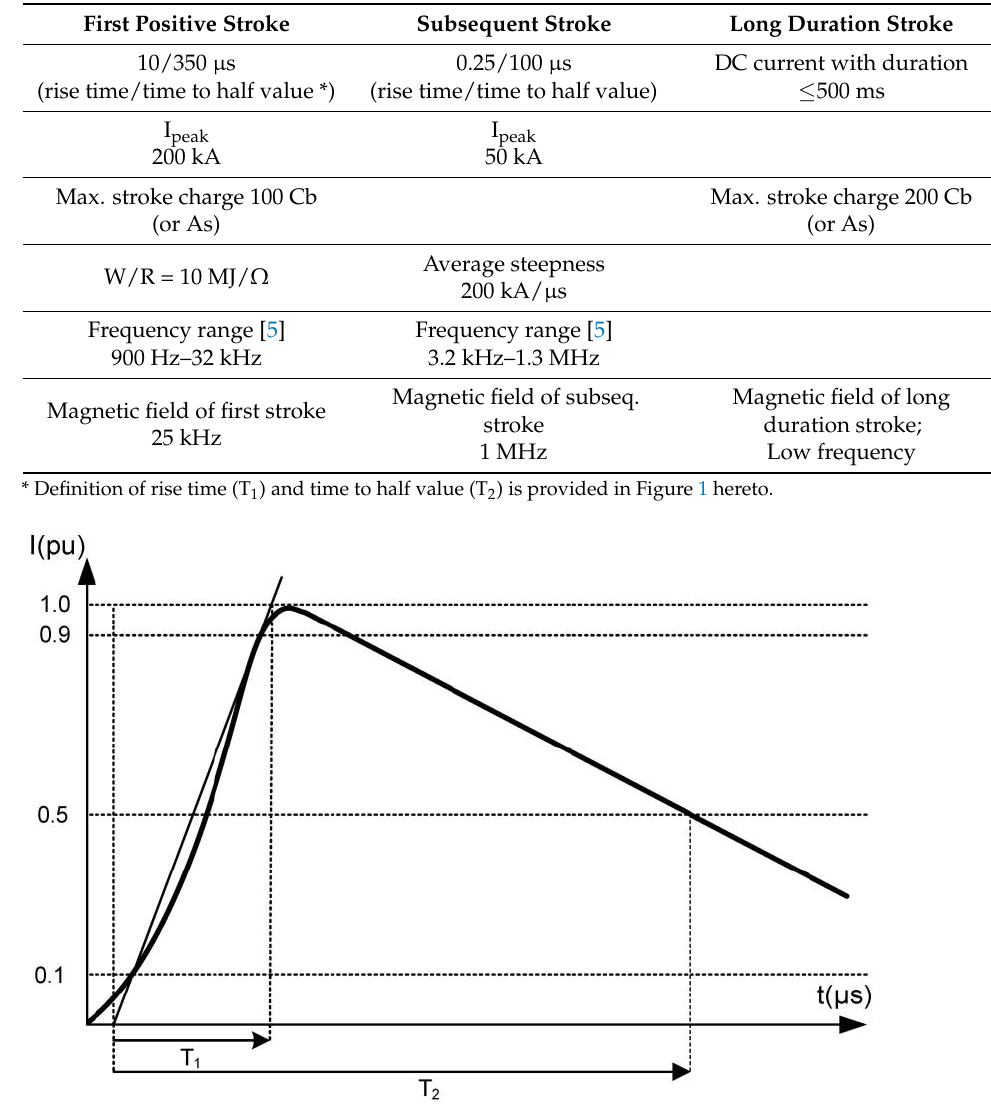
Table 2. Classification of lightning stroke types and characteristics [1].